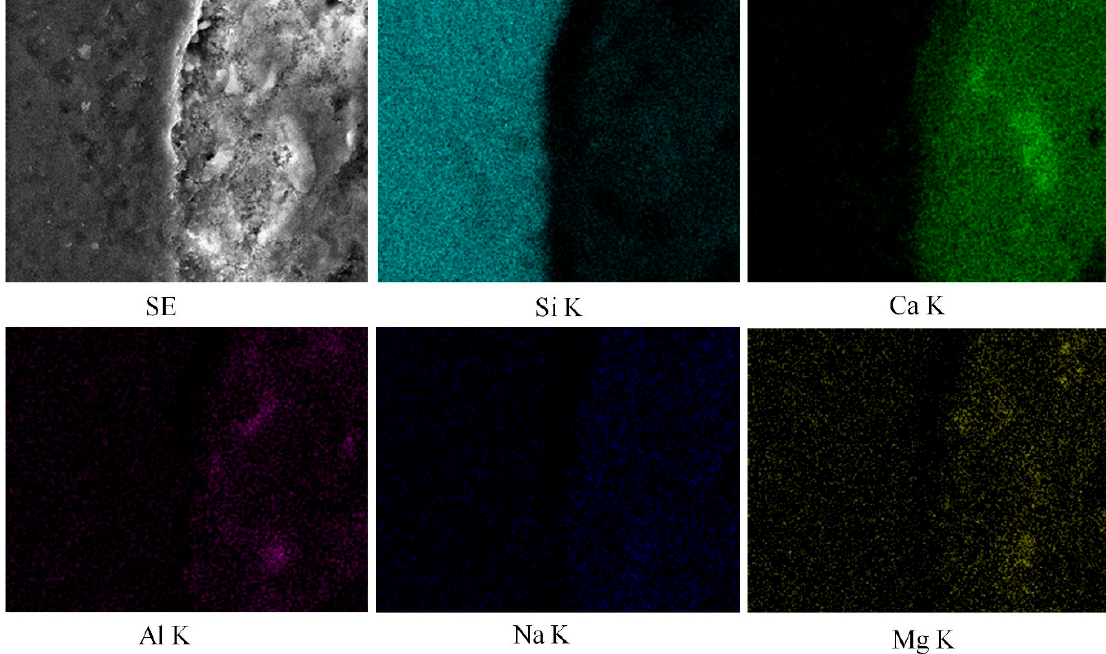
Figure 10. EDS mapping results of concrete specimens made with granite, OPC, and silica fume.